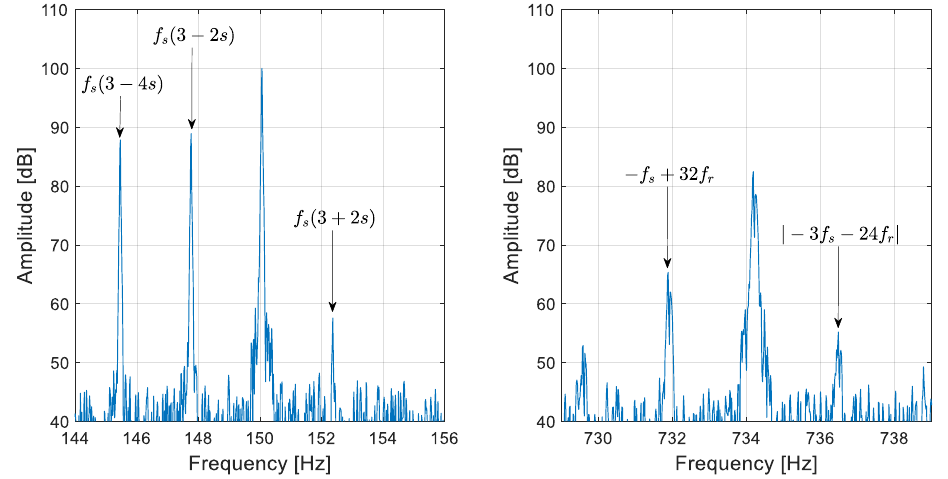
Figure 18. ZSC spectrum measured during laboratory tests of a motor with a delta winding Figure18. ZSCspectrummeasuredduringlaboratorytestsofamotorwithadeltawindingconfiguration